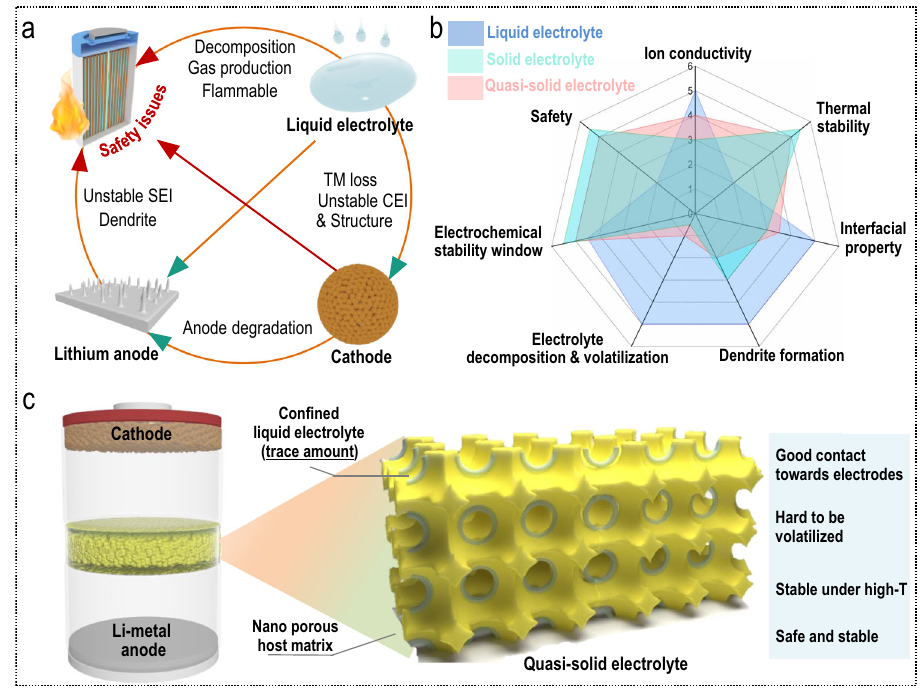
Fig. 1 The importance of using a nonliquid electrolyte for safe lithium-metal batteries. a Safety hazards induced by using traditional liquid electrolytes. b Radar chart of the advantages of quasi-solid electrolytes (compared with typical liquid electrolyte and solid-state electrolyte). c Lithium-metal battery assembled with the proposed quasi-solid